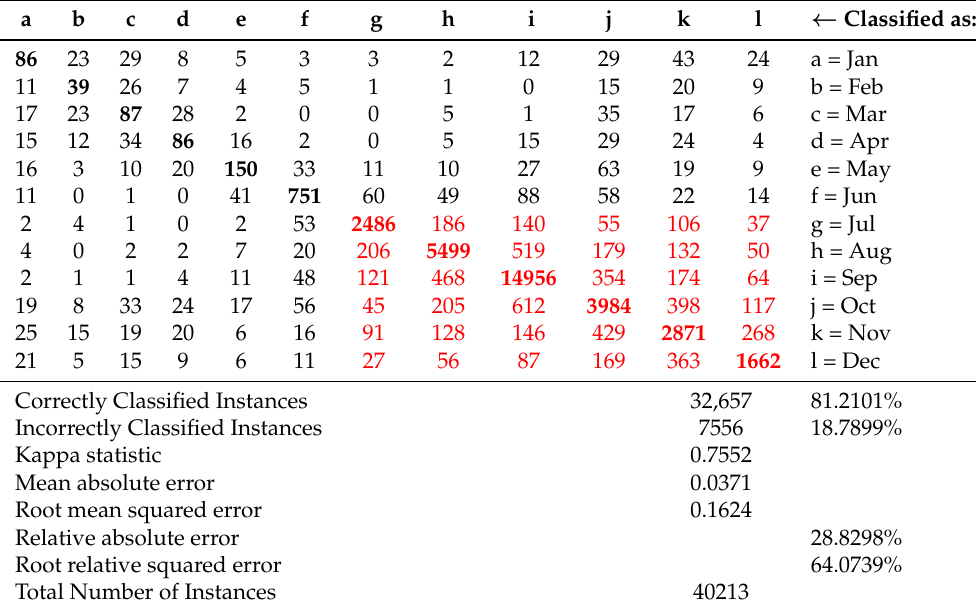
Table 3. Error Matrix of Month Classification in testing